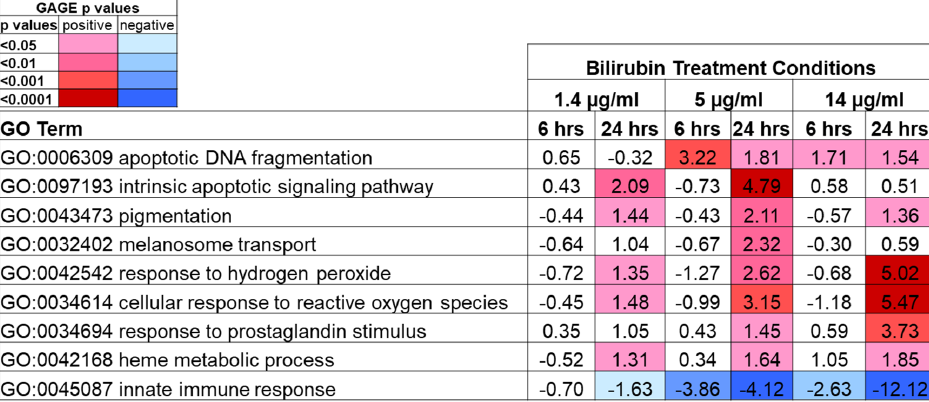
Figure 7. Key modulated biological pathways based on Gene Set Enrichment Analysis treated with different concentrations of bilirubin on human neonatal keratinocytes. Data are shown as log10 of GAGE p -values (negative represents inhibition, positive represents activation). n = 8/group. Color code indicates p -value range.